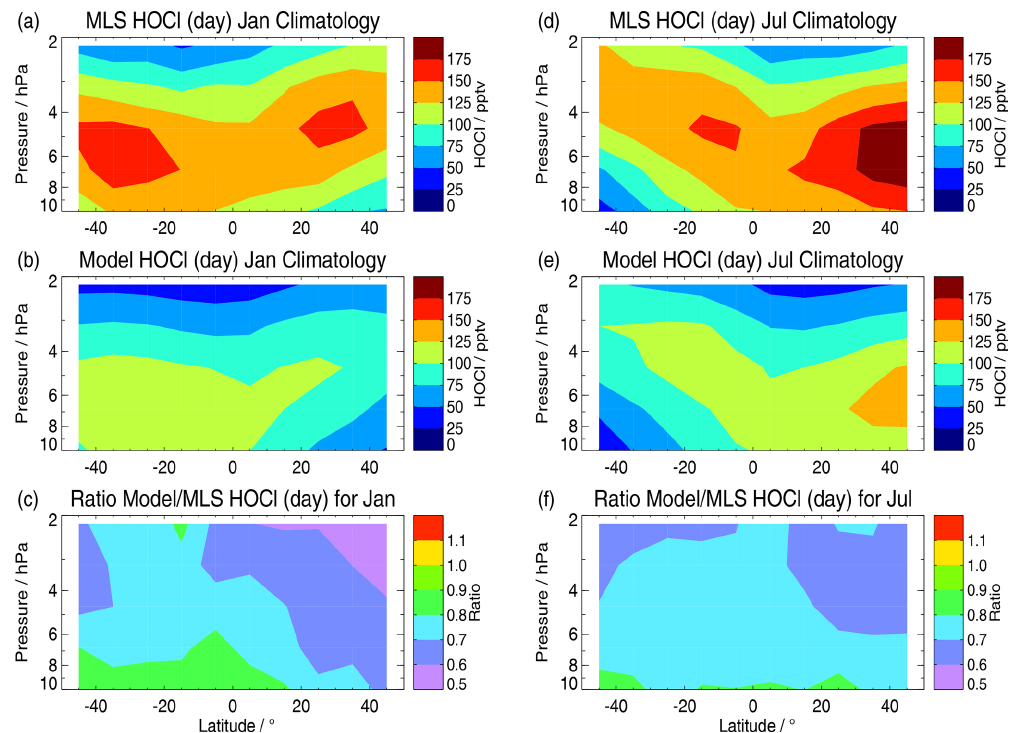
Figure 6. Same as Fig. 1 except for climatological (2005–2020) HOCl daytime values from MLS and the model (see text for more details); the vertical range for useful MLS HOCl data (and for related trend analyses) is 10 to 2.2hPa.